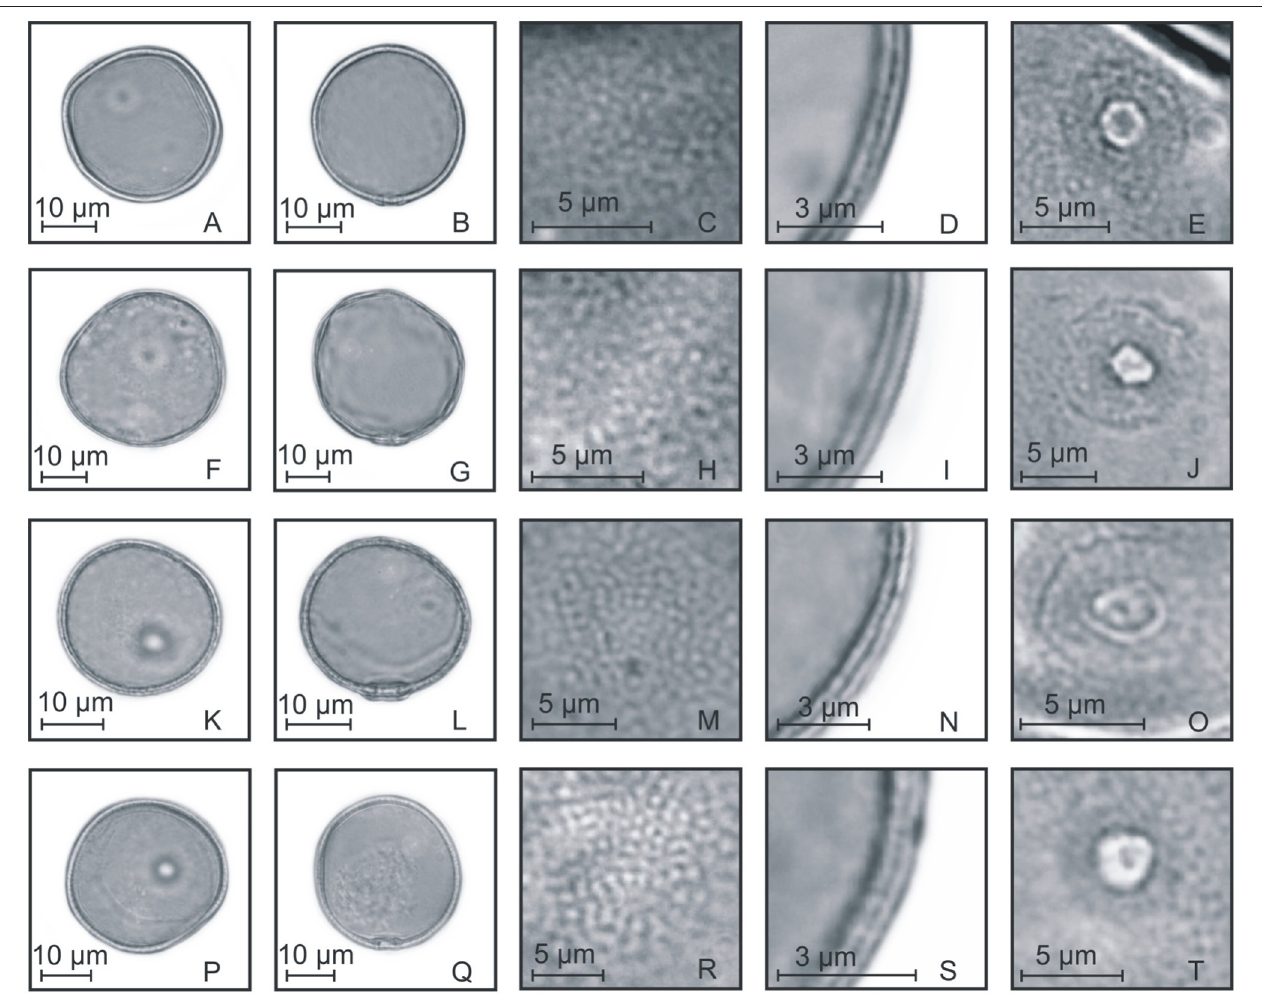
FIGURE 7 | Pollen grains of the subfamilies Pooideae and Panicoideae. (A–E) Melica sp.: PV (A) , EV (B) , detail of ornamentation (C) , detail of the thickness of the exine (D) , and detail of the aperture (E) ; (F–J) Hordeum stenostachys : PV (F) , EV (G) , detail of ornamentation (H) , detail of the thickness of the exine (I) , and detail of the aperture (J) ; (K–O) Piptochaetium montevidense : PV (K) , EV (L) , detail of ornamentation (M) , detail of the thickness of the exine (N) , and detail of the aperture (O) ; (P–T) Paspalum urvillei : PV (P) , EV (Q) , detail of ornamentation (R) , detail of the thickness of the exine (S) , and detail of the aperture (T)